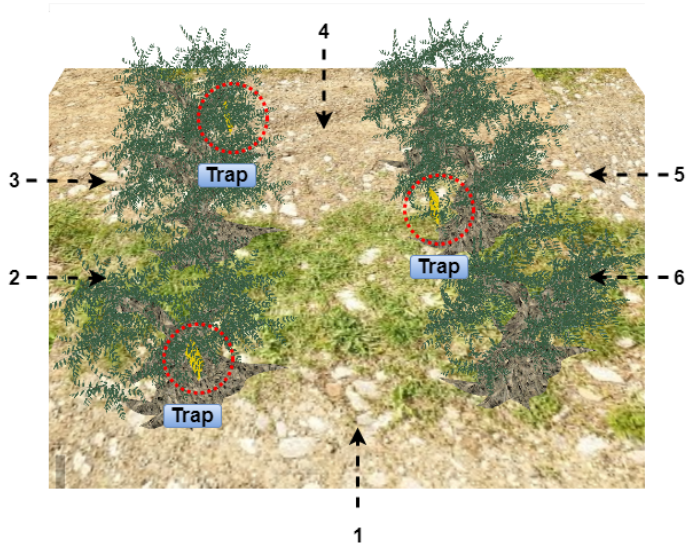
Figure 17. UGV validation strategy.